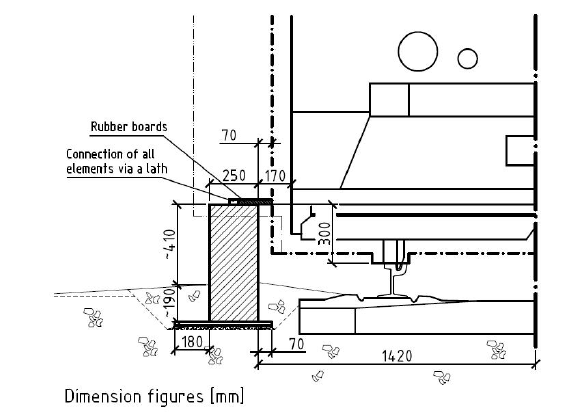
Figure 9. Detail of modified MNAS execution.